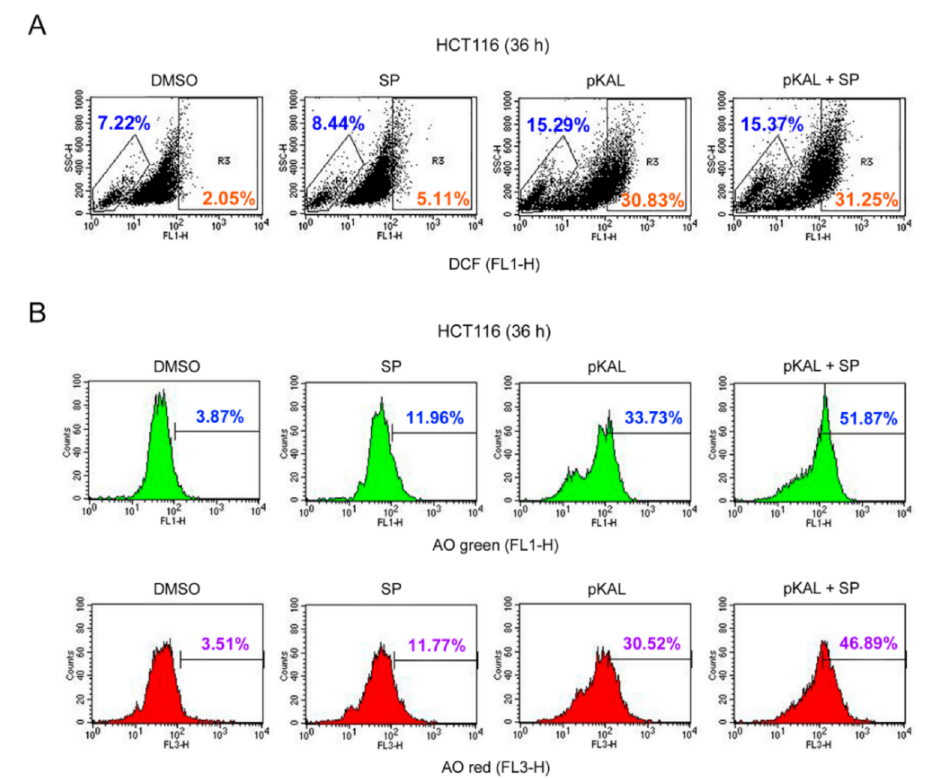
Figure 6. Effect of the c-Jun N-terminal kinase (JNK) inhibitor SP600125 on the regulation of ROS, DNA conformational change, and acidic vesicles induced by pKAL: HCT116 cells were grown with 50 µ g/mL pKAL for 12 h, then treated with 2 µ g/mL SP600126 (SP), and cultured for an additional 24 h: ( A ) flow cytometric analysis of DCF-stained cells; ( B ) flow cytometric analysis of AO-stained